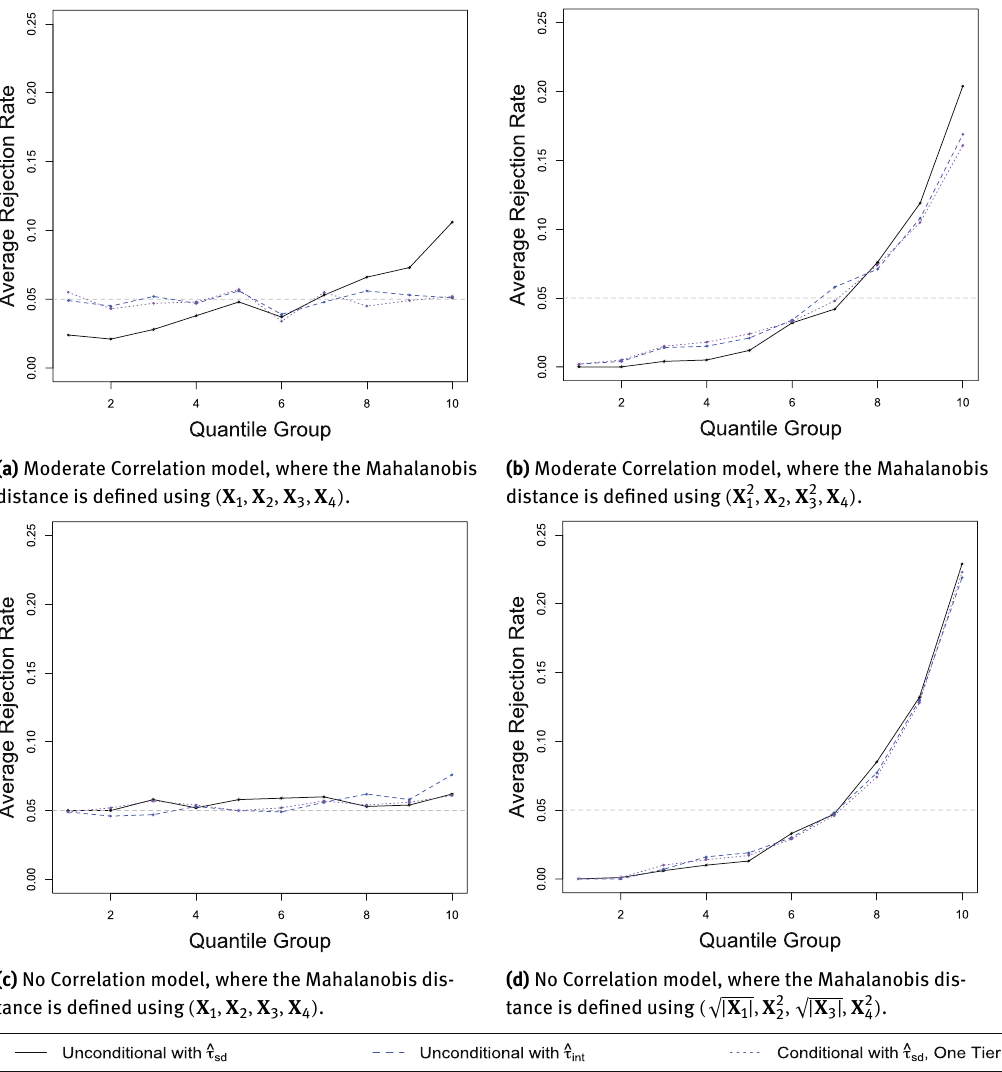
Figure 12: The rejection rate of the randomization tests within each quantile group of the Mahalanobis distance when the po- tential outcomes were generated from the Moderate Correlation model (24) or the No Correlation model (25). In Figures 12a and 12c, the Mahalanobis distance is defined using the raw covariates ( X 1 , X 2 , X 3 , X 4 ) ; in Figures 12b and 12d, the Mahalanobis distance is defined using the functions of the covariates that are linearly related with the potential outcomes for each model ( ( X 2 1 , X 2 , X 2 3 , X 4 ) and ( √ | X 1 |, X 2 2 , √ | X 3 |, X 2 4 ) , respectively).